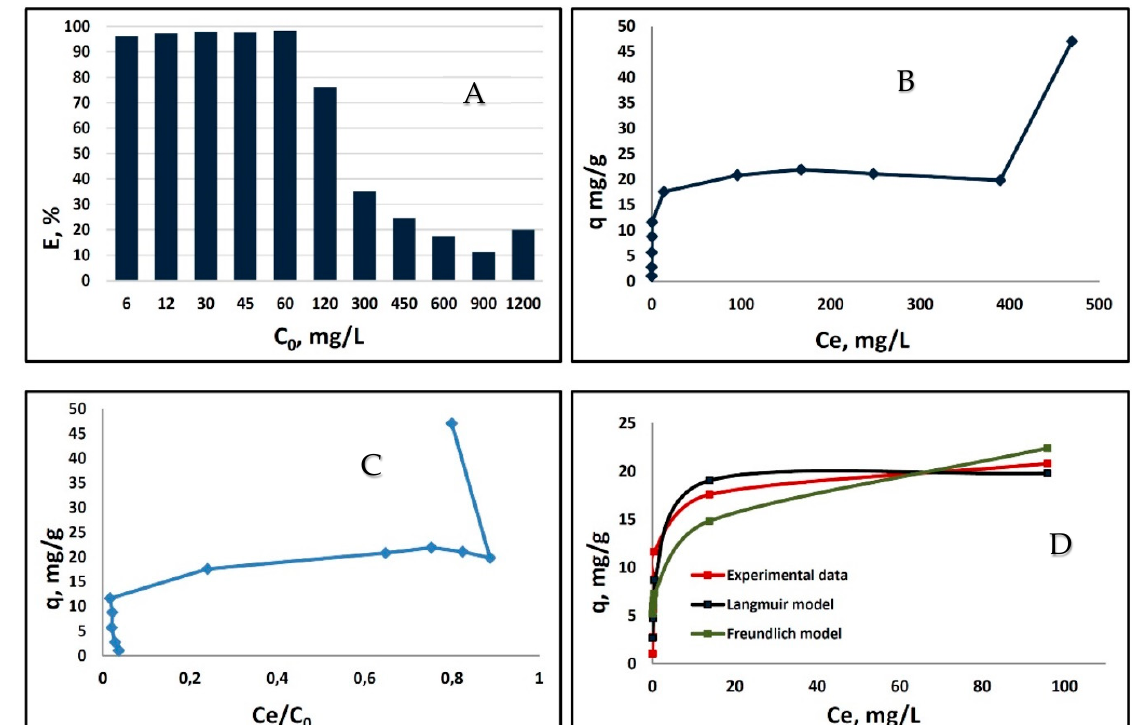
Figure 1. Batch isotherm study for Ag + sorption onto bLTF: ( A ) isotherm of Ag + adsorption onto bLTF for entire concentration range; ( B ) bar chart of a sorption efficiency of metal onto bLTF depending on the initial concentration of Ag + ; ( C ) modified BET isotherm, which presents adsorption as a function of a ratio C e /C 0 ; ( D ) the fit of first sorption step to Langmuir and Freundlich models.